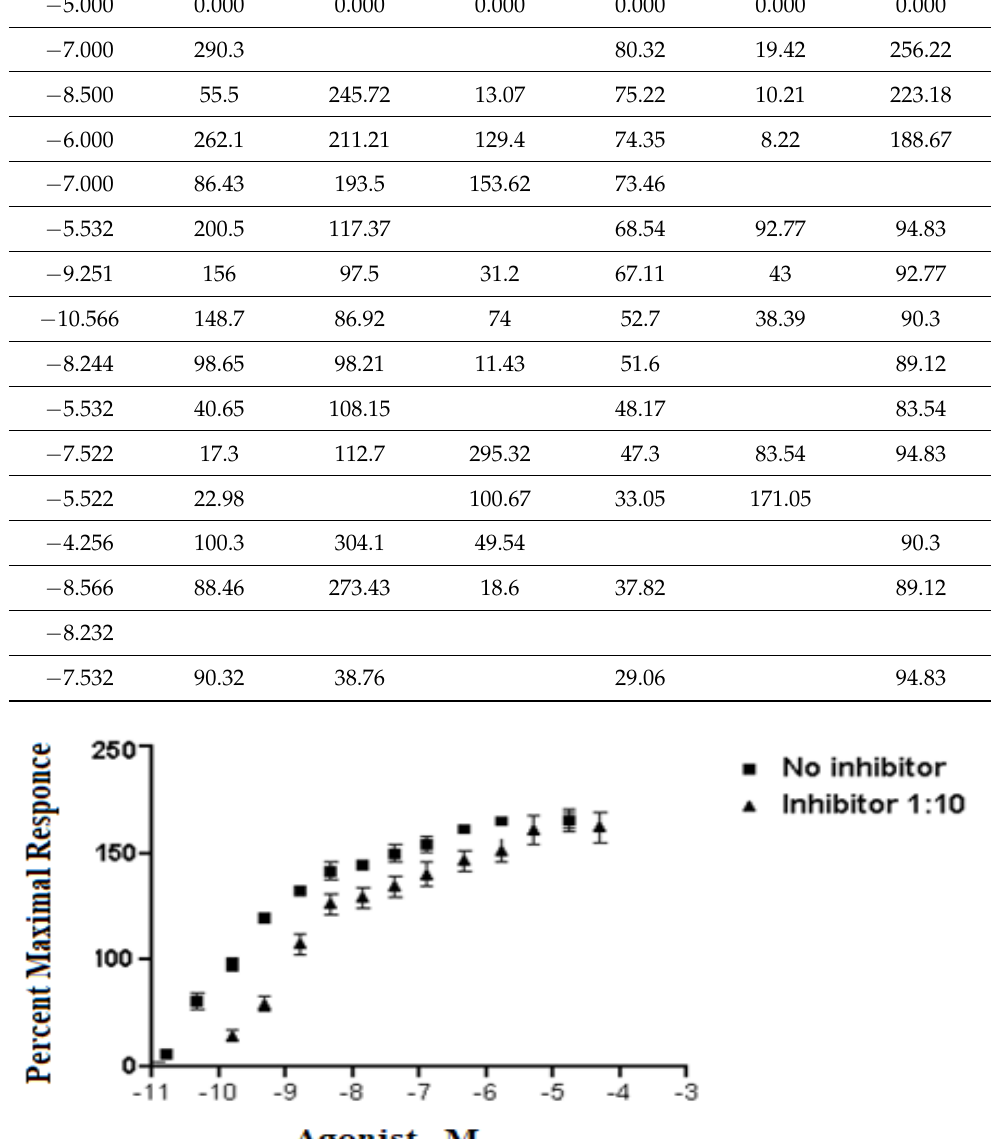
tration, expressed in exponential notation (Figure 1). The Y values are responses in arbitrary units